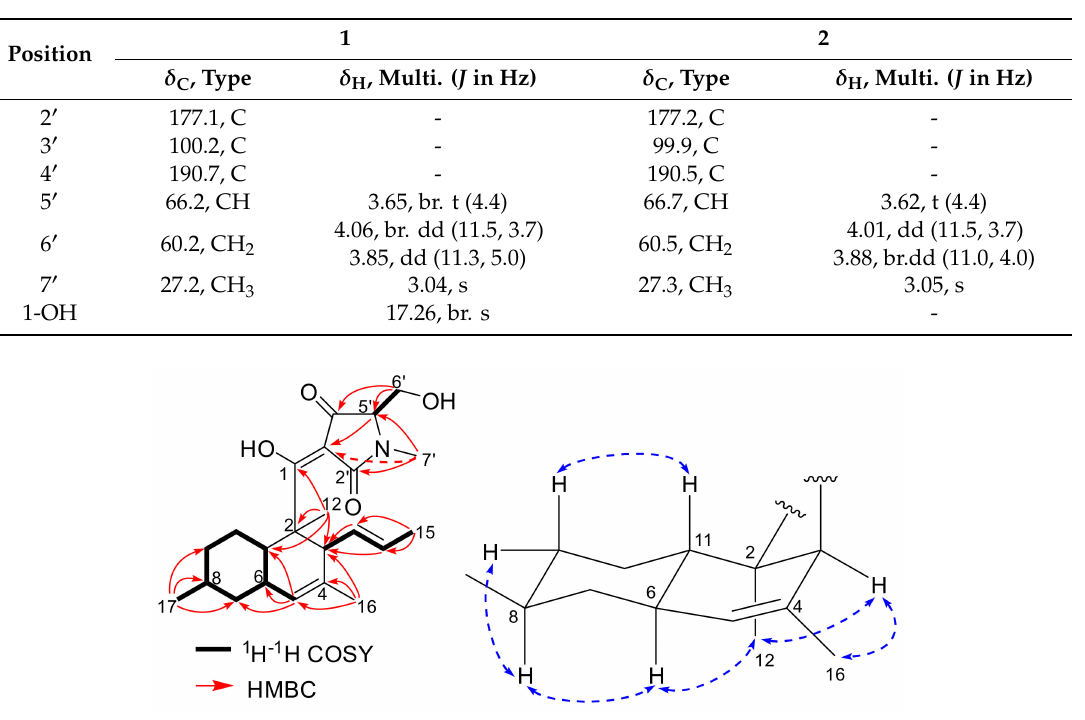
Figure 2. Selected 1 H- 1 H COSY, HMBC ( left ) and ROESY (H → H, right ) correlations of 1 .